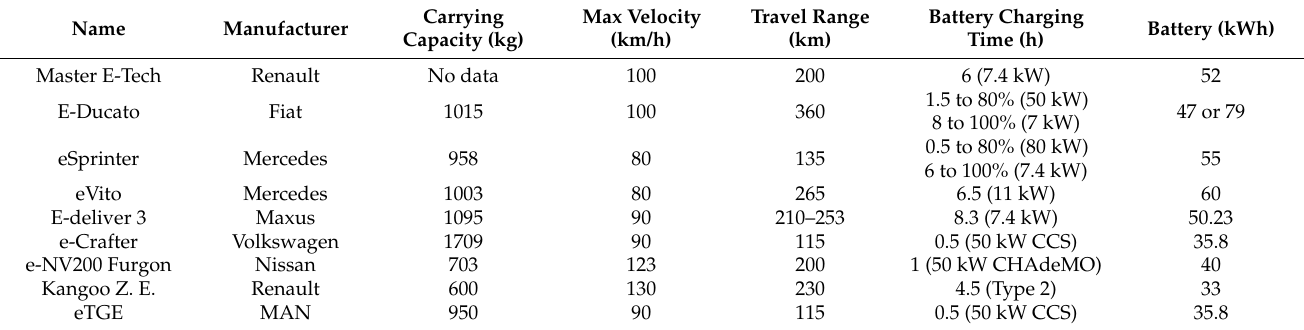
Table 1. Examples of electric delivery vehicles and their technical parameters